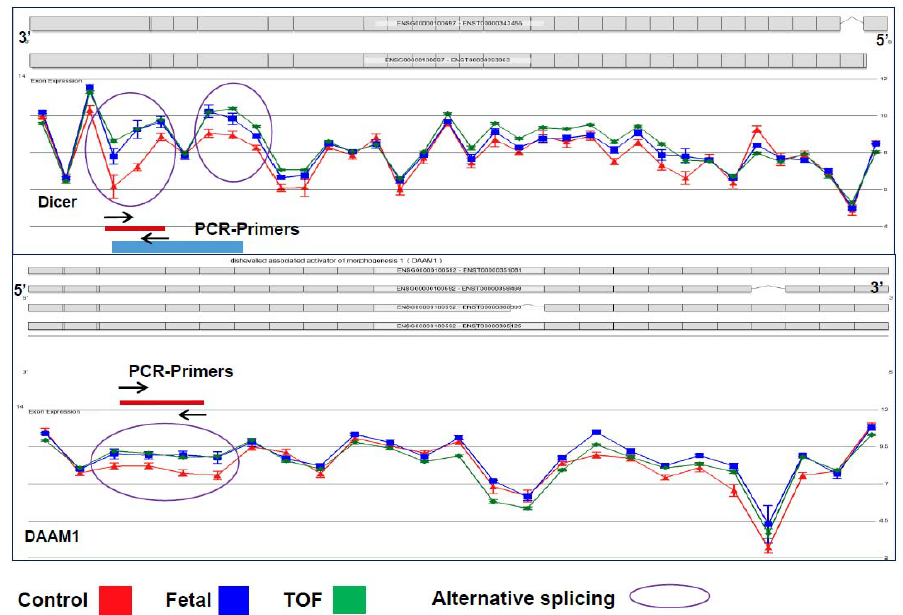
Figure 1. Representative examples of alternative splicing of two genes (DICER1 and DAAM1). Circled regions represent exonic regions where multiple probes had a significant change in probe intensity level between the normally developing and control subjects and the subjects with TOF. Note that there is not a significant difference in the probe intensities in other regions of the genes. In addition, note that the blue line represents probe intensities of samples from fetal tissue which differed significantly from the control tissue in the circled regions but did not differ from the samples from subjects with TOF. Standard error bars are shown for each probe. N : TOF = 16, Control = 8, Fetal = 3.